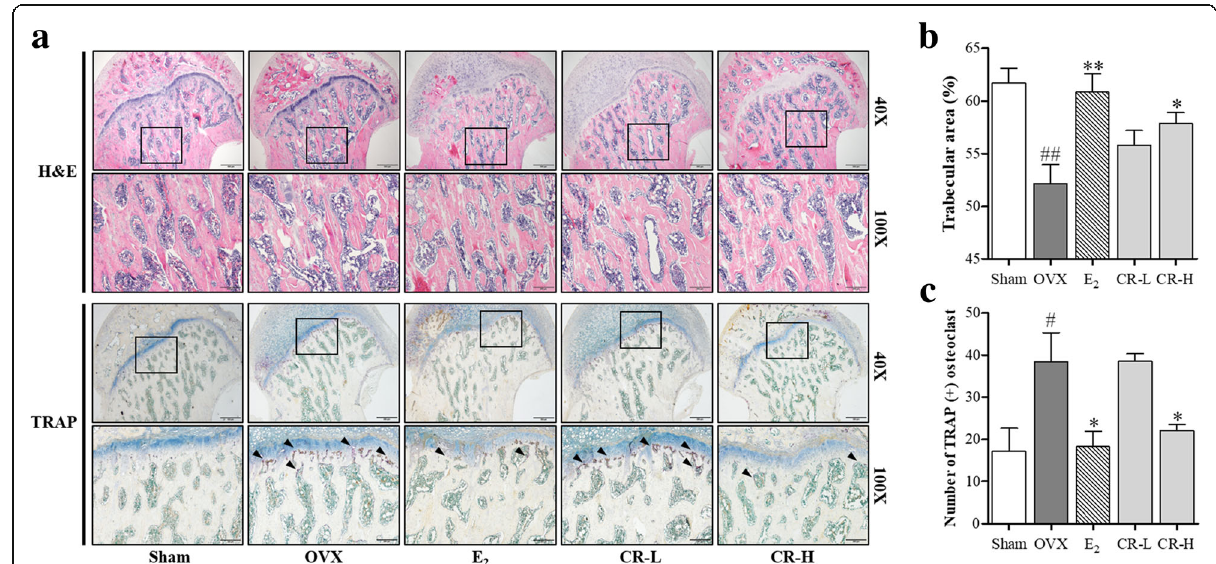
Fig. 8 Effect of CR on the trabecular area in OVX-induced bone loss in rats. Histological examination of tissue sections from the femoral heads of rats using H&E and TRAP staining. a One representative femur from each group was captured using a light microscope, and the arrowheads indicate the osteoclasts. (40X and 100X magnification, Scale bars are 500 and 200 μ m, respectively). b Trabecular area was measured using the Image J software and c number of osteoclasts was counted using the Image J software. Data represent the mean ± S. E of each experimental groups. ## p < 0.01, # p < 0.05 compared with the Sham and ** p < 0.01, * p < 0.05 compared with